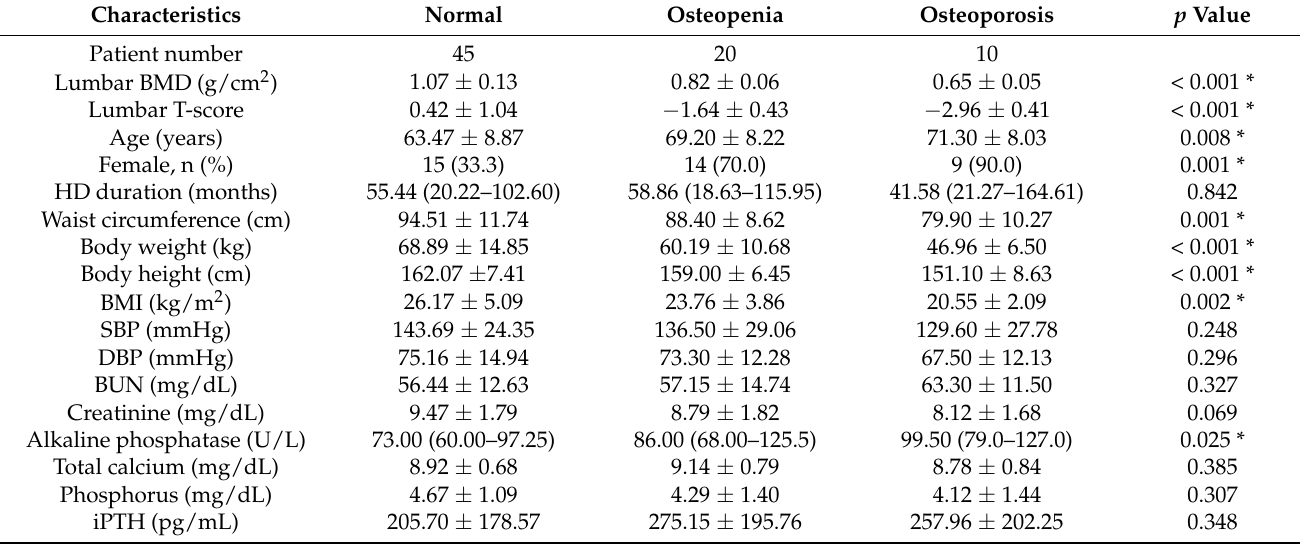
Table 2. Clinical characteristics by different lumbar T-score (normal, osteopenia, and osteoporosis) of the hemodialysis